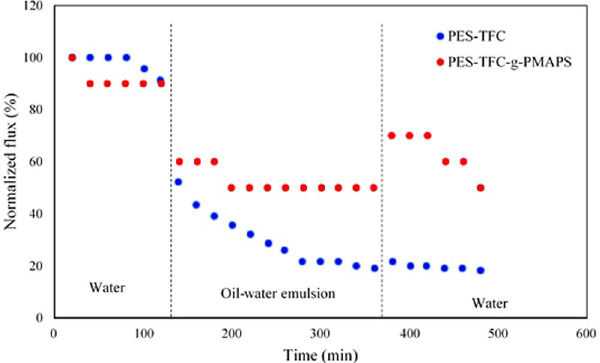
Figure 10. Comparison between the water flux recovery of single-skinned and double-skinned TFC membranes during three steps: (i) pure water flux for 120 min, (ii) oil-water emulsion water flux for 260 min and (iii) pure water for 120 min after washing with DI